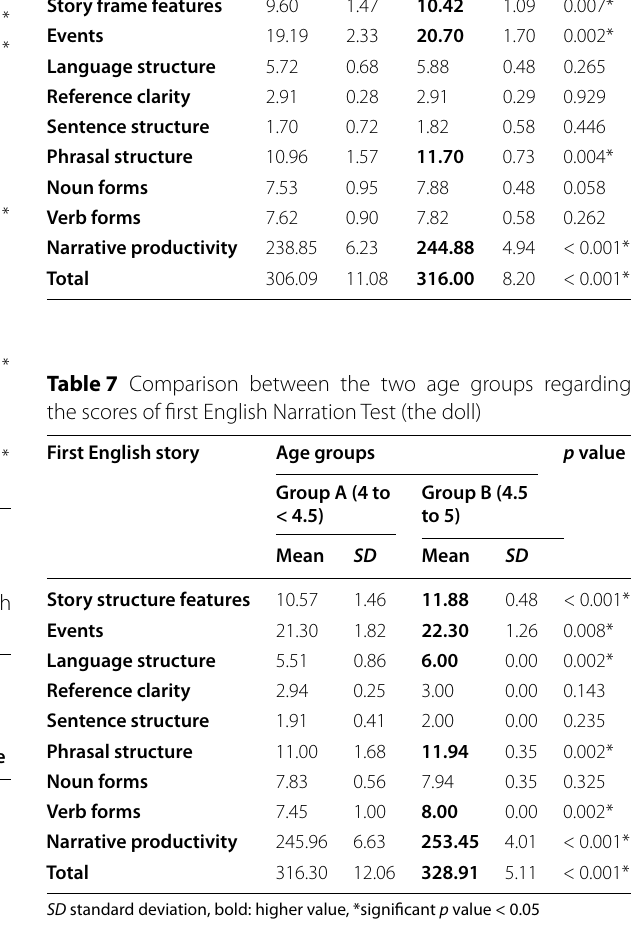
SD standard deviation, bold: higher value, *significant p value <